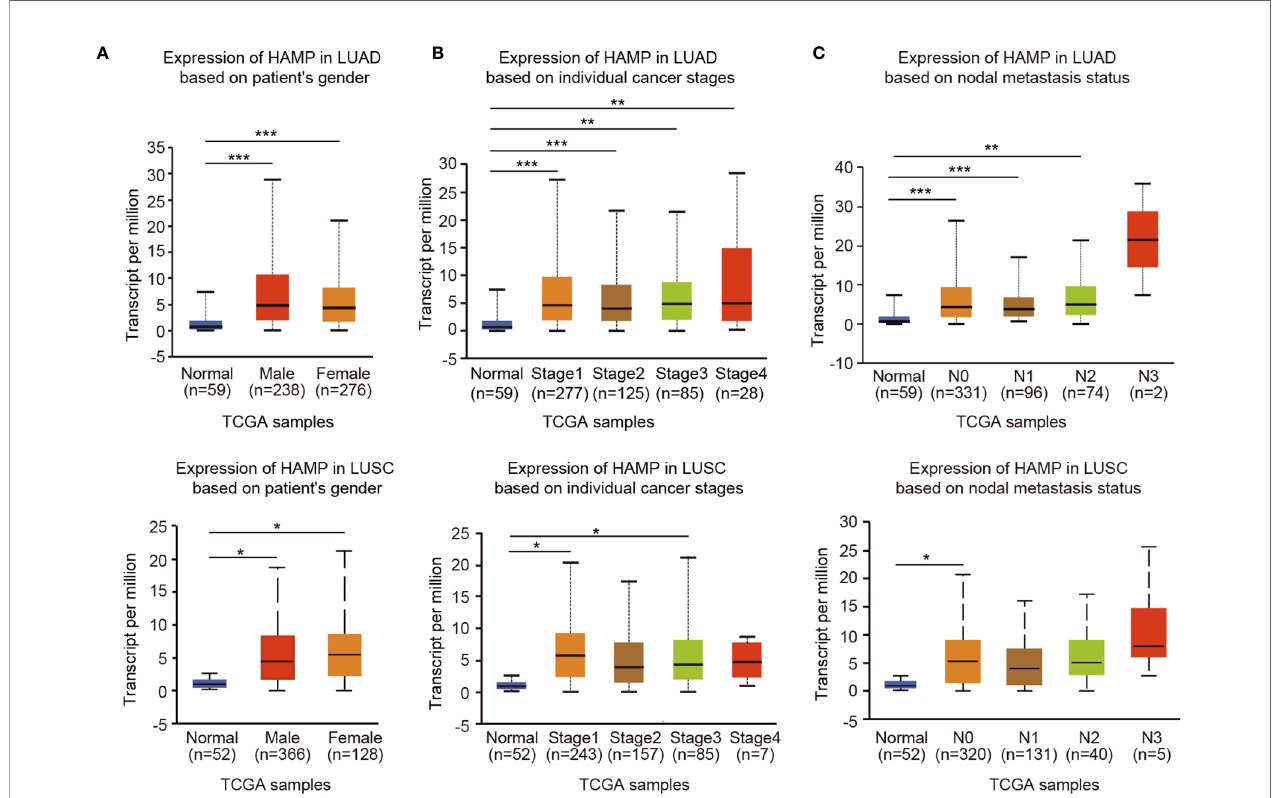
FIGURE 3 | Box plots evaluating hepcidin expression among different groups of patients based on clinical parameters using the UALCAN database. Analysis is shown for sex (A) , cancer stage (B) , and metastasis (C) . N0: no regional lymph node metastasis; N1: metastases in 1 to 3 axillary lymph nodes; N2: metastases in 4 to 9 axillary lymph nodes; N3: metastases in 10 or more axillary lymph nodes. *p < 0.05, **p < 0.01, ***p <